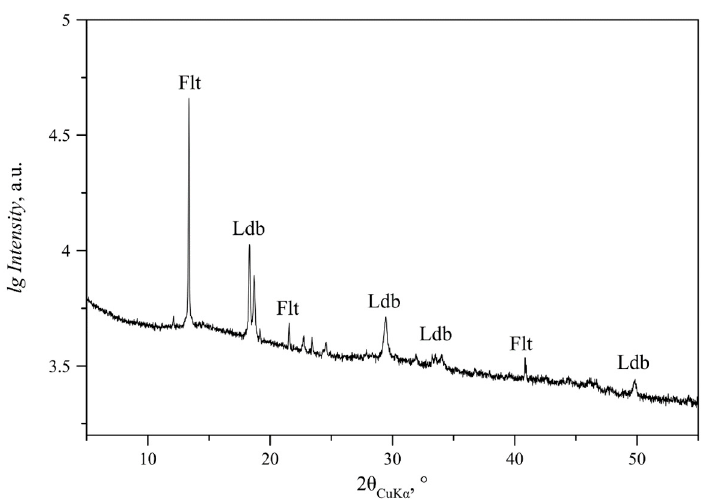
Figure 6. PXRD pattern of precipitate obtained at Mg/(Mg + Mn) = 30% (SC series). Notation: Flt—falottaite MnC 2 O 4 ∙ 3H 2 O; Ldb—solid solution with lindbergite structure. Flt—falottaite MnC 2 O 4 · 3H 2 O; Ldb—solid solution with lindbergite